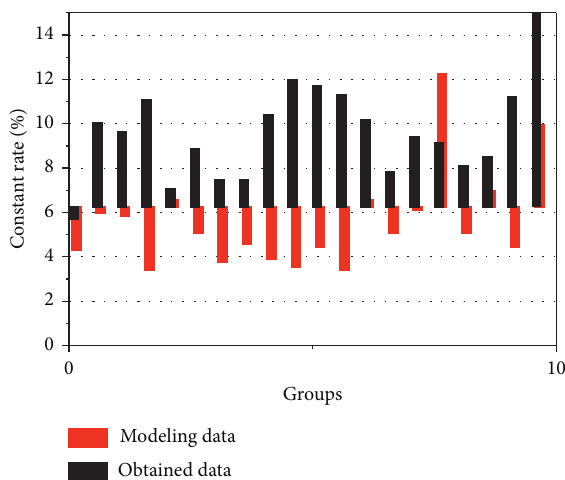
Figure 3: Comparison of model correspondence results.